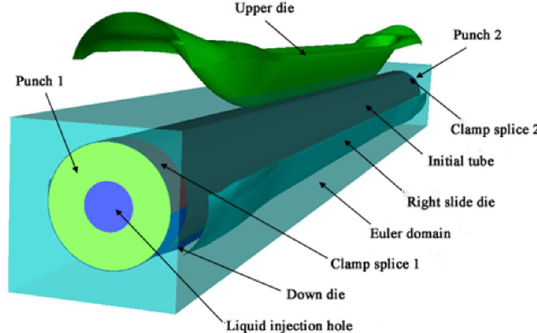
Figure 26 Flow–solid coupling model of high pressure